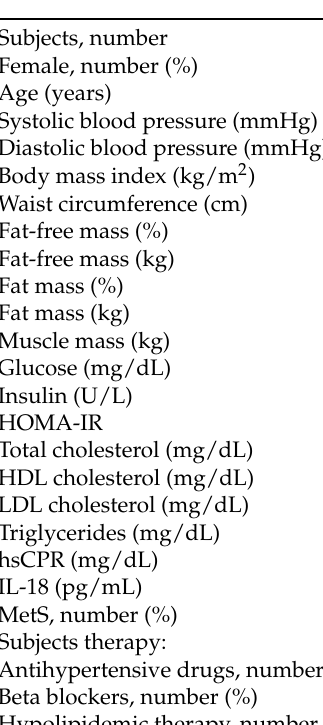
Table 1. Study participant